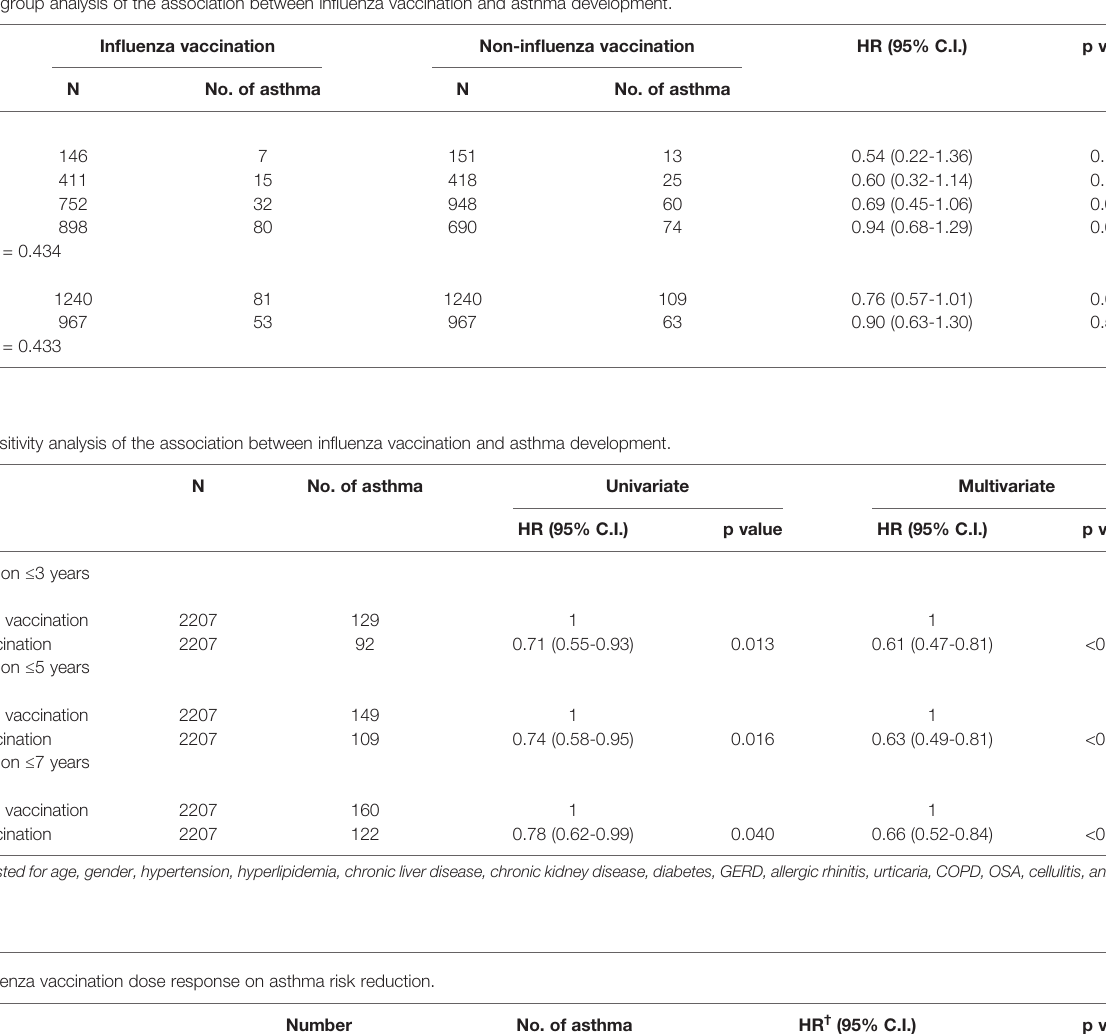
TABLE 3 | Subgroup analysis of the association between in fl uenza vaccination and asthma development.